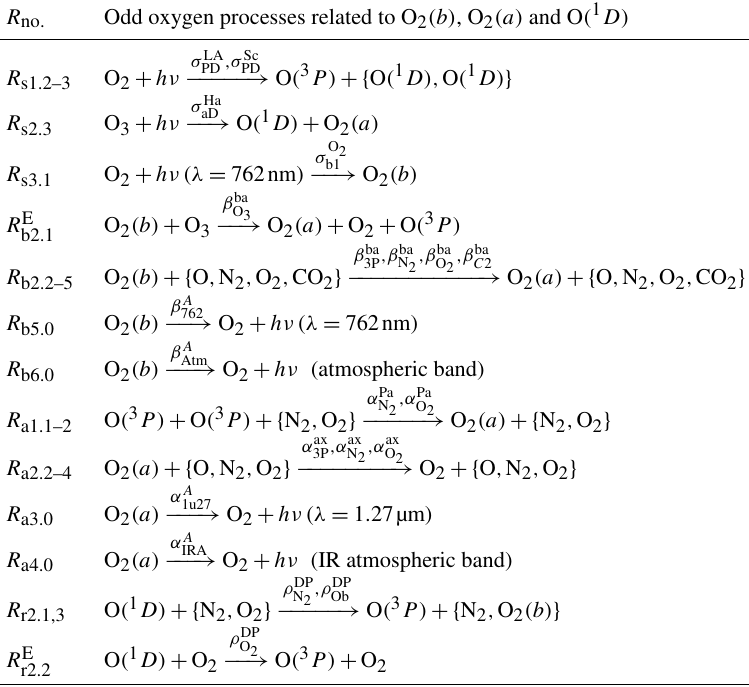
Table 3. Processes of the model of Mlynczak et al. (1993) modified by Sharp et al. (2014) are hereafter referred to as the M model; see Sect. 3.2.1. Processes of O 2 and O 3 photolysis occur in sunlight conditions. The processes marked with a character E are not considered in the MAC model shown in Tables 6 and 7 because they were not listed in the online version of the JPL 2015-year database (Burkholder et al., 2015) and were replaced by other relevant up-to-date processes. R no